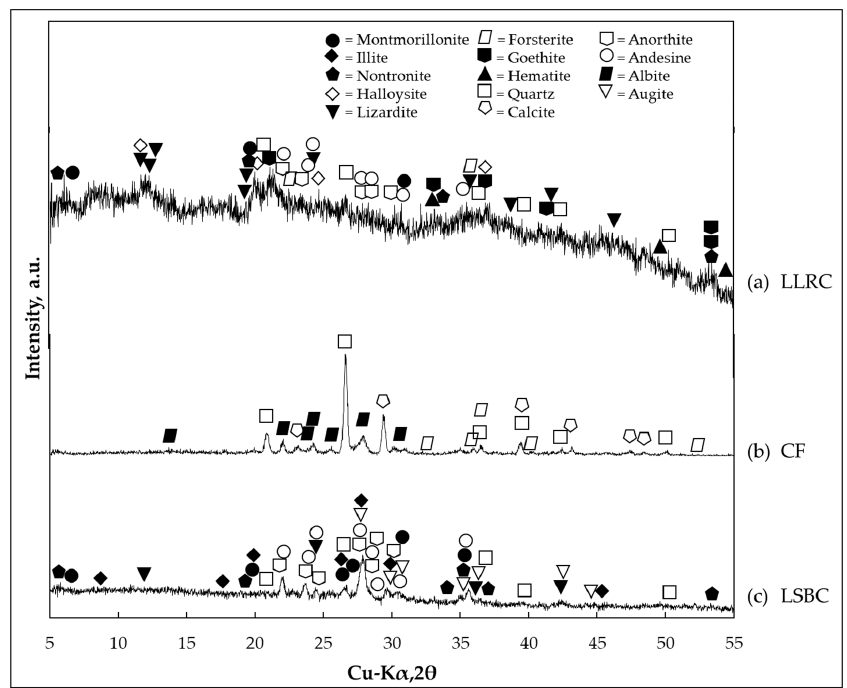
Table 2. Chemical Composition of Raw Materials .